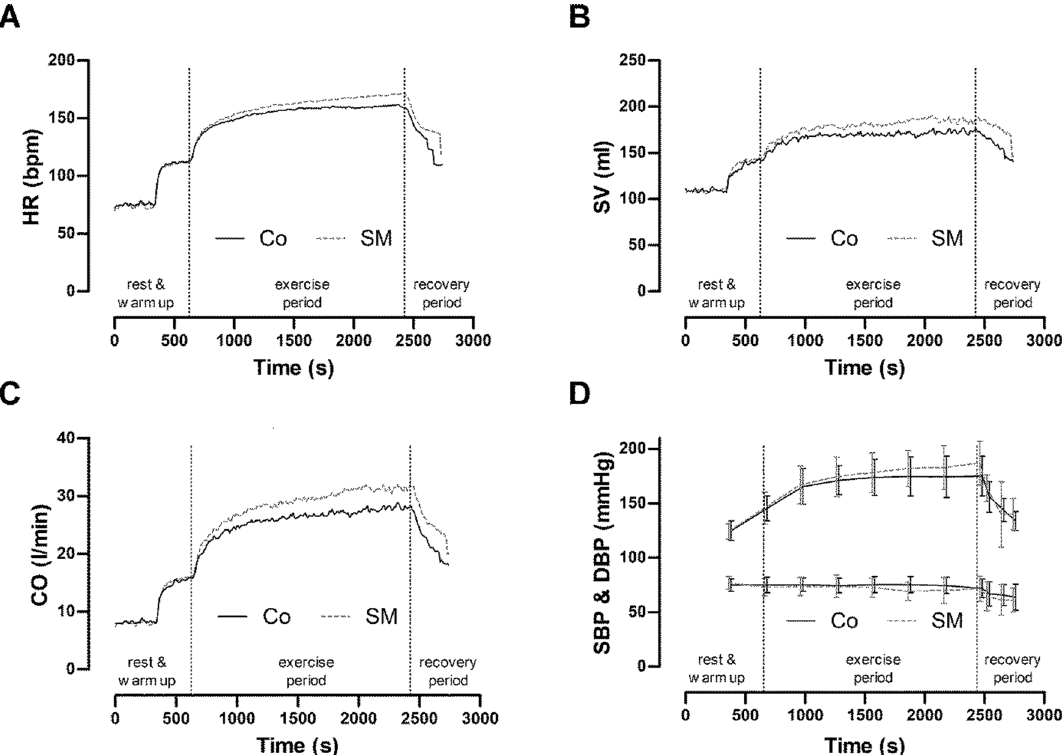
Figure 3. Graphs showing the mean cardiac responses (n = 13) during the continuous load test with (SM) and without (Co) a surgical mask. ( A ) HR: heart rate; ( B ) SV: stroke volume; ( C ) CO: cardiac output; ( D ) SBP & DBP: systolic & diastolic blood pressure. Rest values were determined immediately prior to